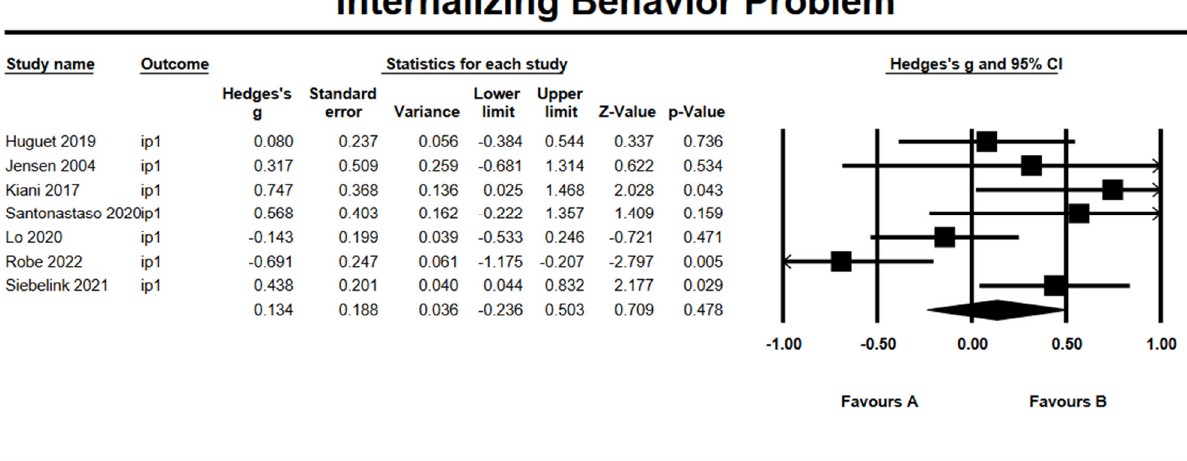
Figure 6. Forest plots of effect size for internalizing behavioral problem [29,30,33,36–39].